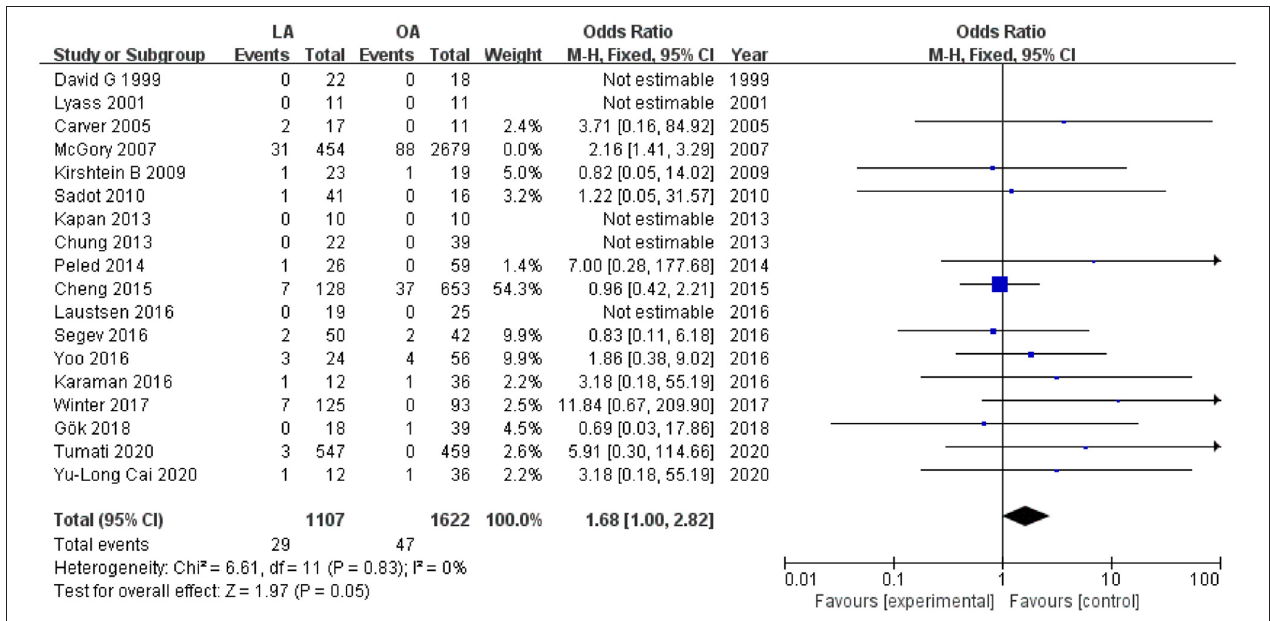
FIGURE 5 | Forest plot for Fetal loss after excluding the study by McGory et al.